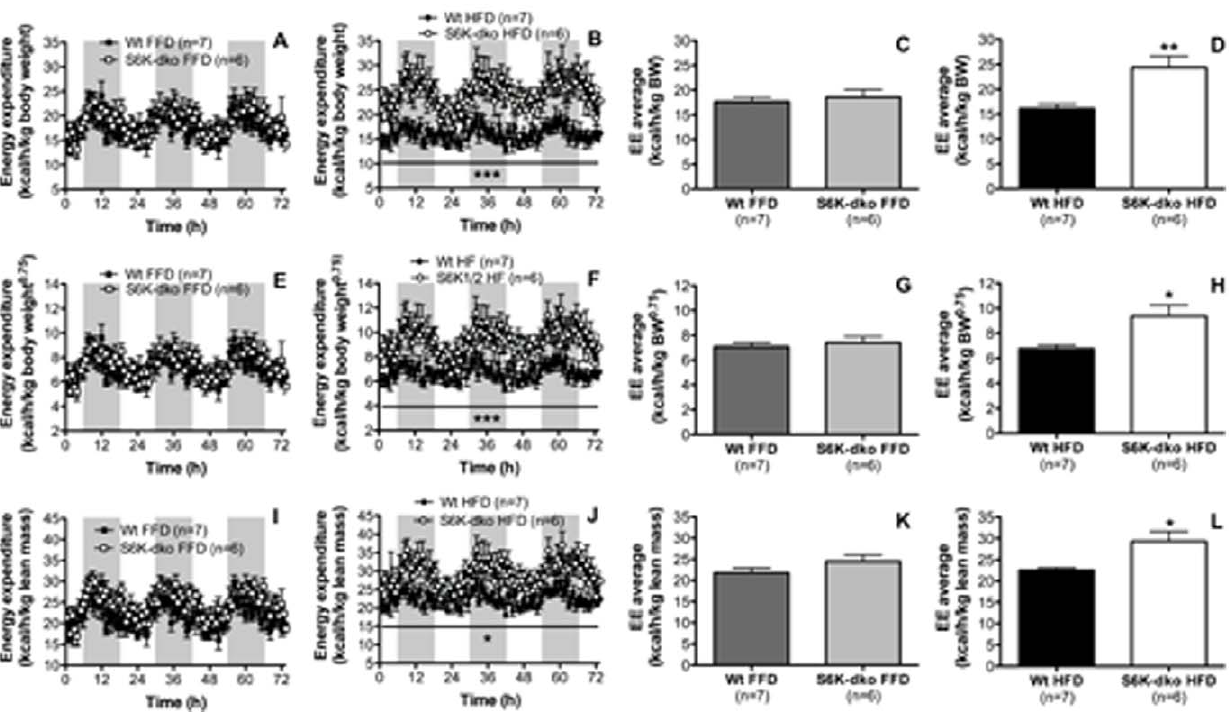
Figure 4. Energy expenditure levels in S6K-dko are diet regulated. Energy expenditure normalized for body weight (B, D), body surface area (F, H) or lean mass (J, L) is higher in S6K-dko than wt mice when fed a high-fat diet. No differences in energy expenditure are observed between S6K- dko and wt control mice fed a fat-free diet (A, C, E, G, I, K). BW, body weight; EE, energy expenditure; FFD, fat-free diet; HFD, high-fat diet. Two-tailed t test * P , 0.05, ** P , 0.01 and two-way ANOVA * P , 0.05, *** P , 0.001. (Fig. 7B), Cpt-1 b ( P , 0.05, n= 6) (Fig. 7D), Acc a ( P , 0.01, n= 6) (Fig. 7F) and Pdk-4 ( P , 0.05, n= 5) (Fig. 7H) compared to muscle from wt controls (n =6–7). In the absence of dietary lipids, however, no such differences were detected (Fig. 7A, C, E, G).